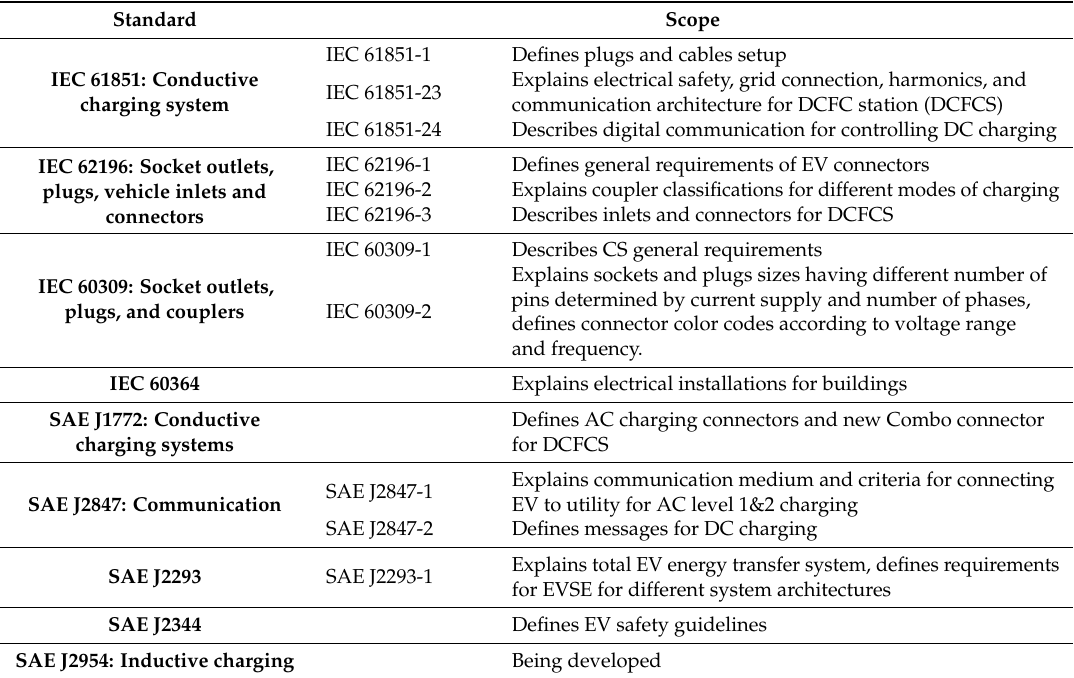
Table 18. Charging standards. Data from [81].